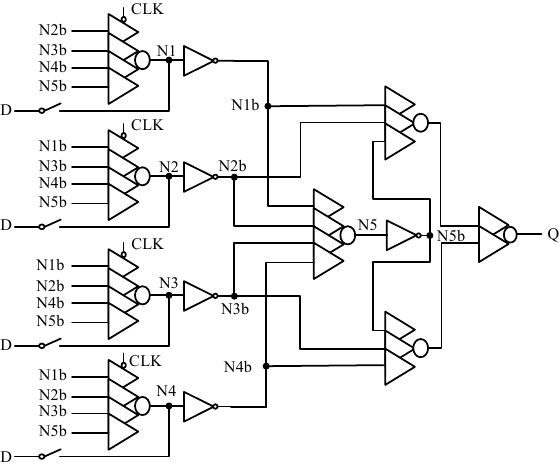
Figure 3. Latch schematic for TNU-latch.